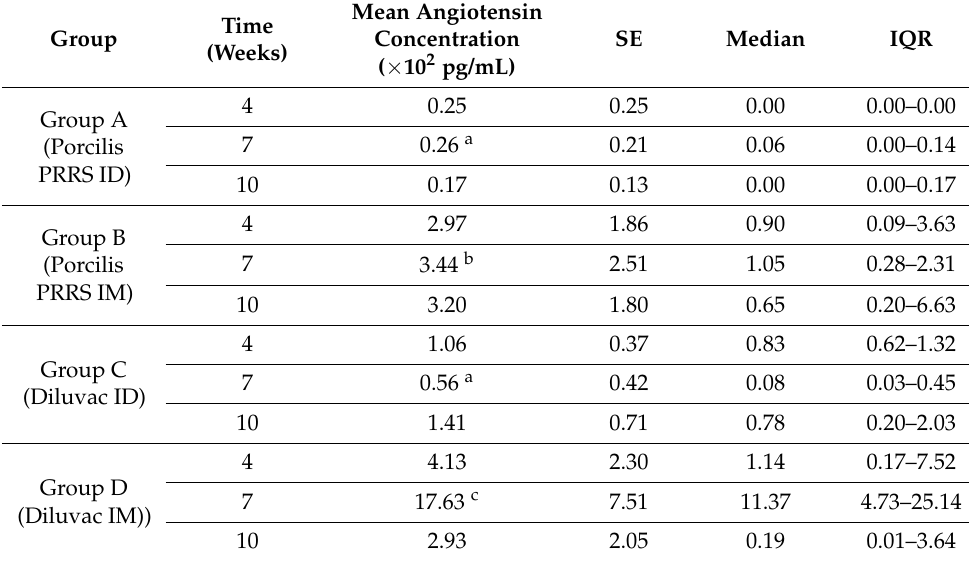
Table 2. Mean, standard error (SE), median and interquartile range (IQR) of angiotensin serum concentrations in all groups and time